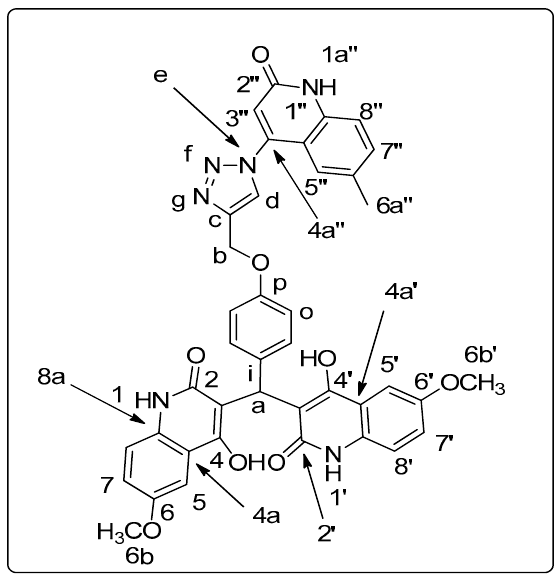
Figure 3. Structure of compound 8f .